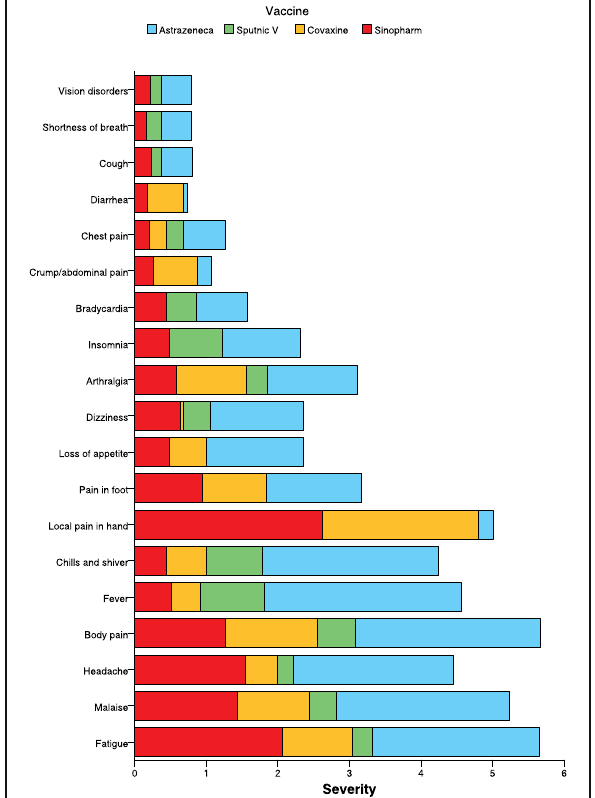
four types of vaccine; ChAdOx1 nCoV-19, Gam-COVID-Vac, BBV152, and BBIBP-CorV